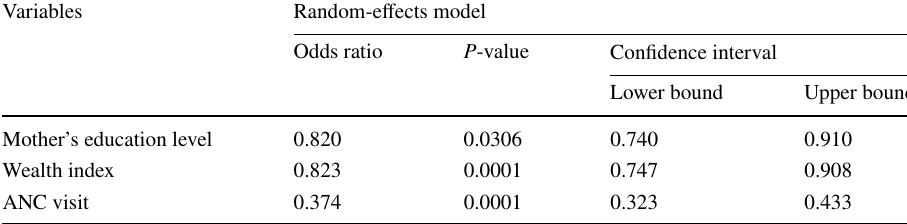
Table 3 Random-effects model estimation (summary effect) of various covariates in 21 developing countries